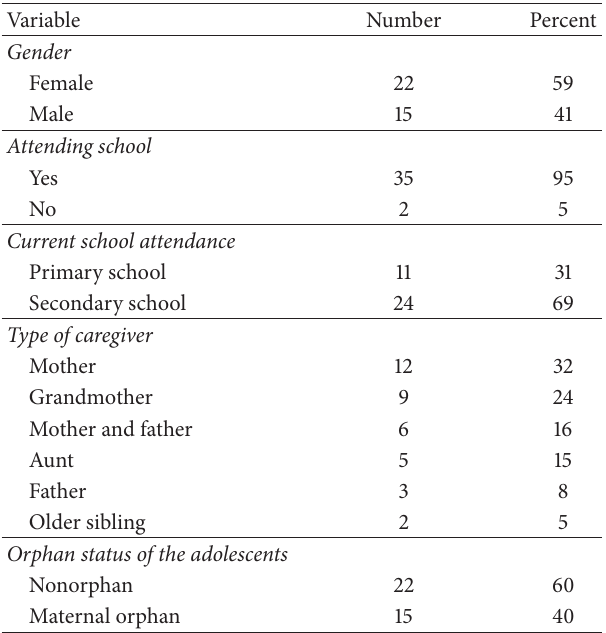
Table 1: Demographic profile of adolescents and relationship with